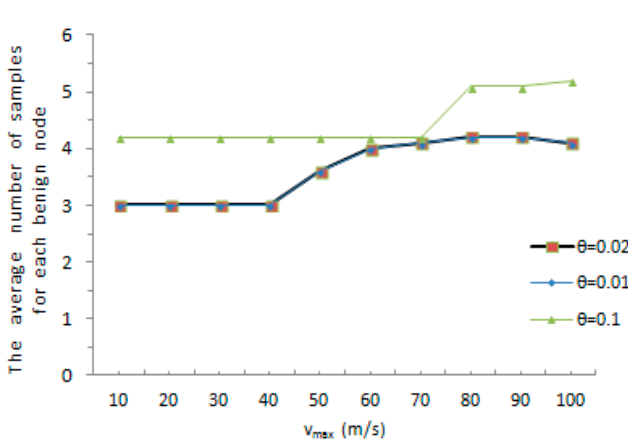
Figure 6. The average number of samples for each benign node.